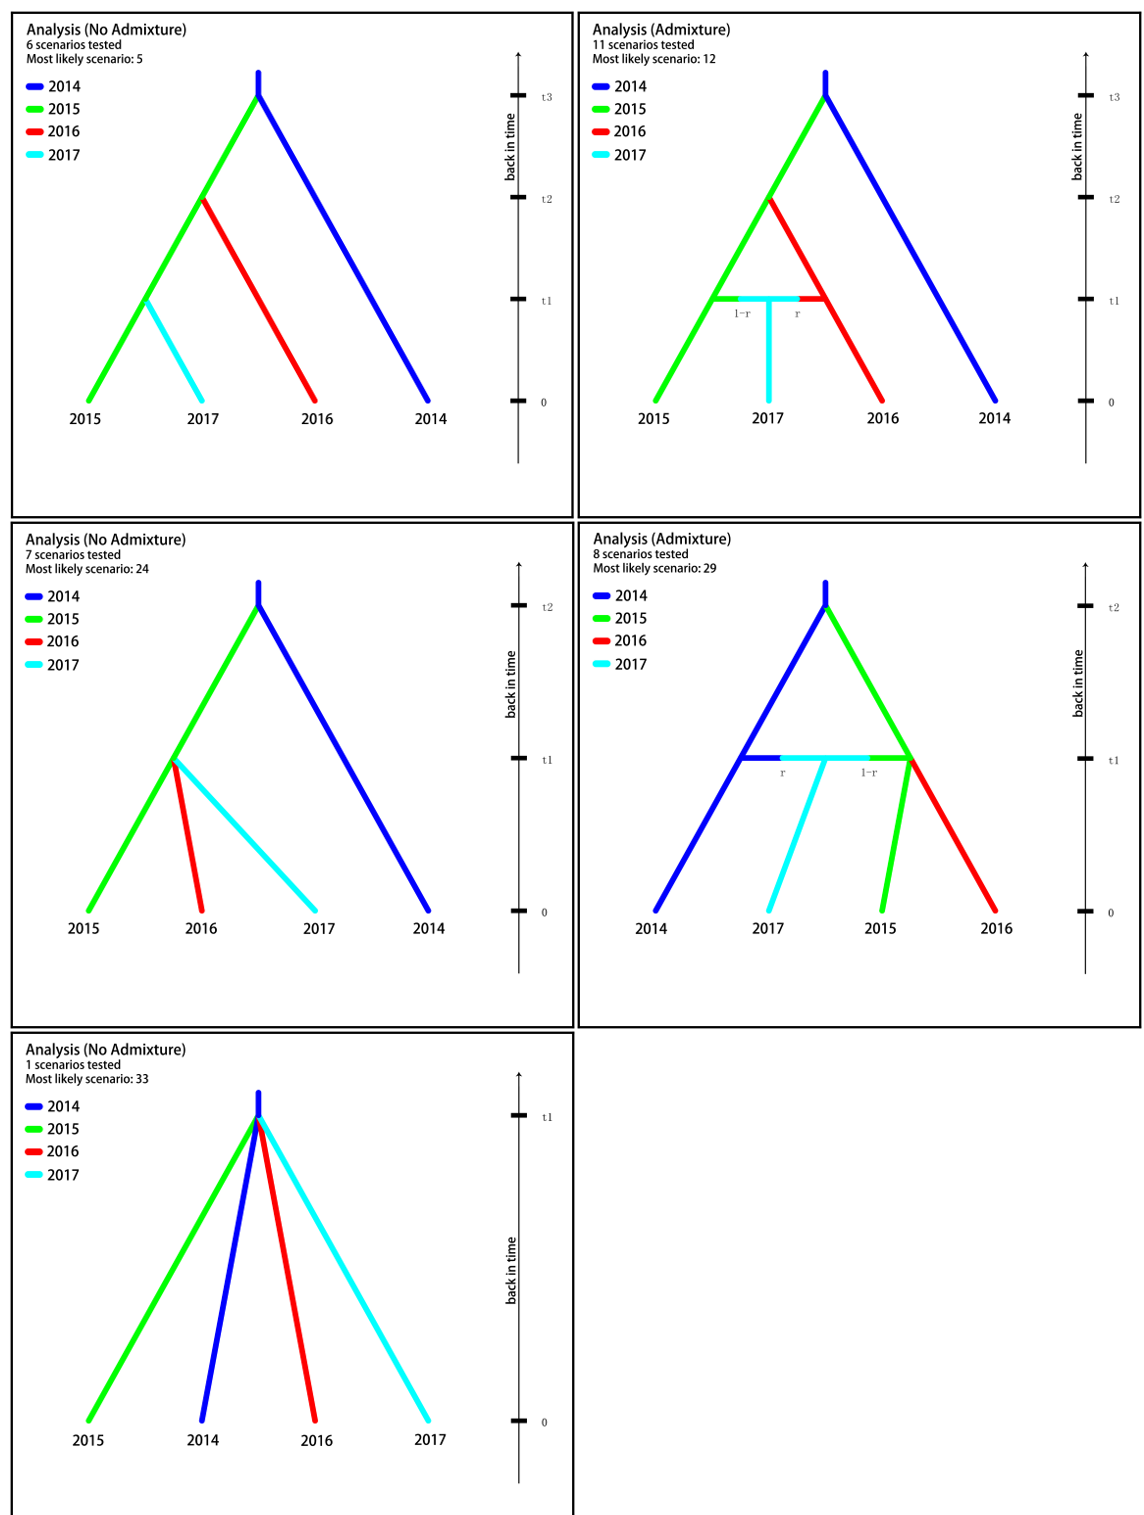
Figure 5. Graphic representation of the five most likely scenarios inferred in DIYABC analysis.